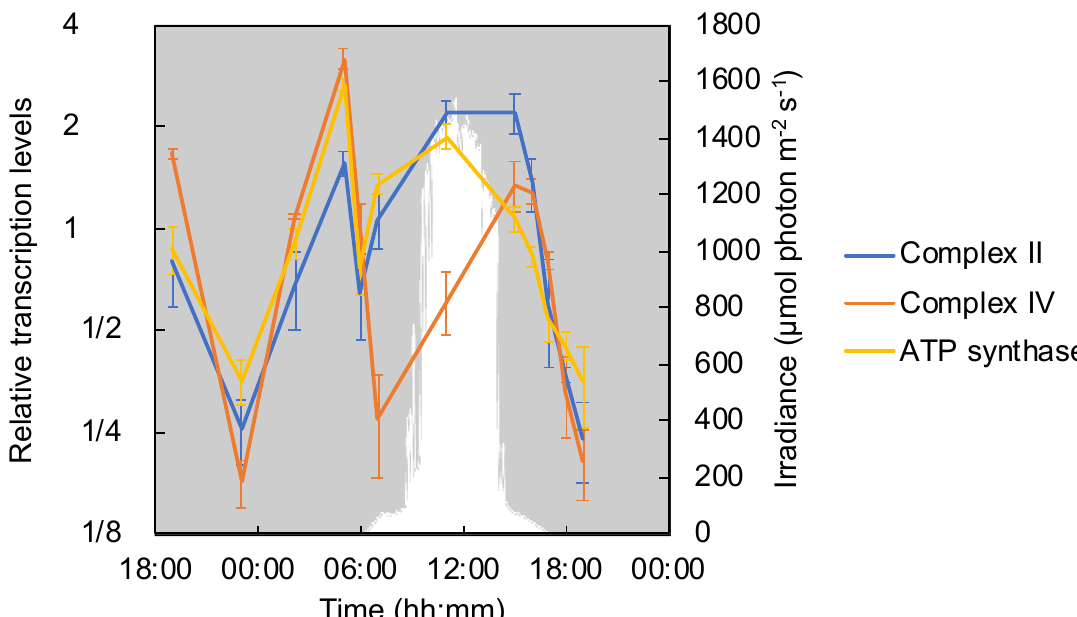
Figure 5. Relative transcription levels of respiratory complex II, IV and ATP synthase. The mean values of the relative transcripts of respiratory complex II (Cagg_1576–1578, blue line), complex IV (Cagg_1519–1522, orange line) and ATP synthase (Cagg_0984—991, yellow line) are shown with standard deviations. The downwelling photon irradiance (PAR; 400–700 nm) is indicated in white.